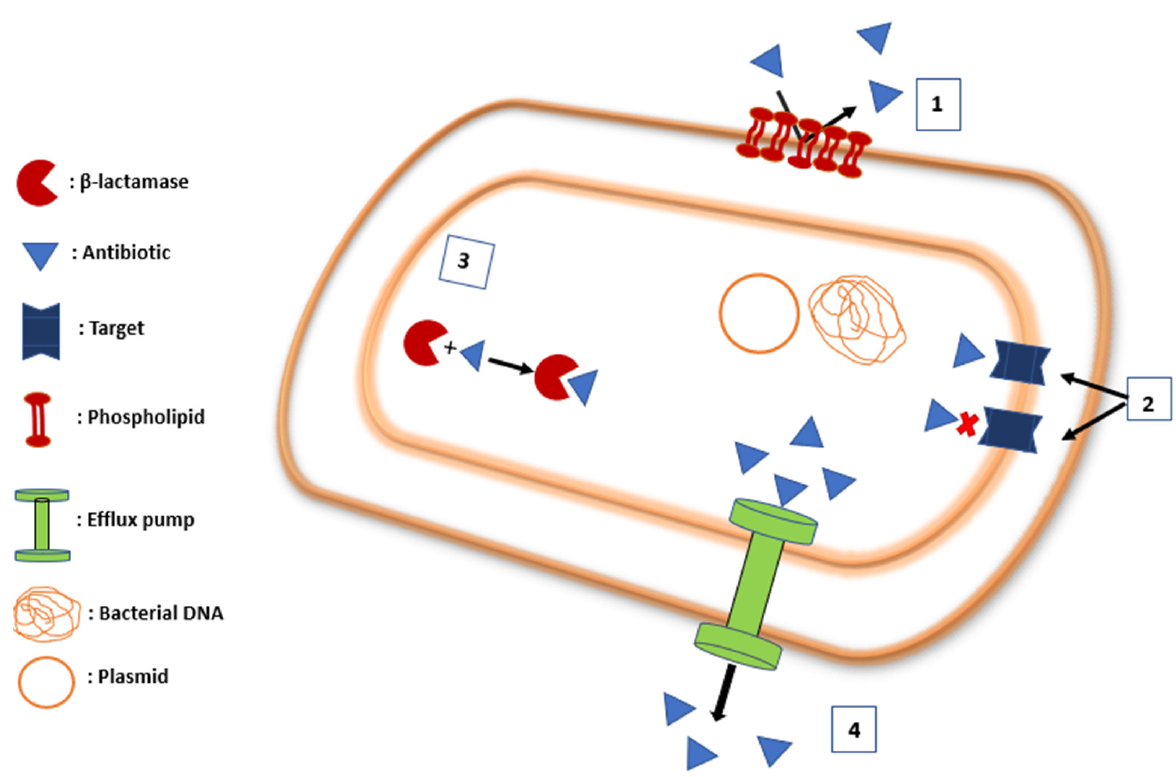
Figure 1 . Potent mechanism of resistance of a bacterium. (1) Membrane impermeability, (2) Target modification, (3) Antibiotic inactivation, (4) Efflux pumps.